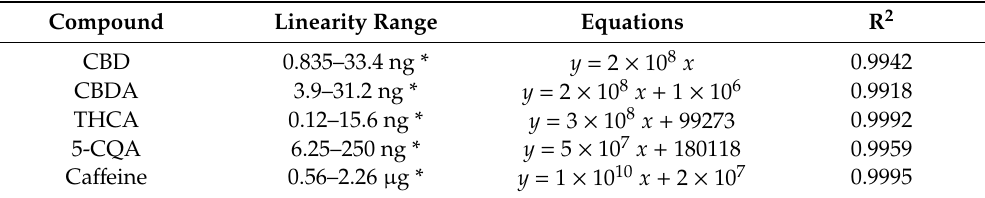
Table 1. Calibration Curves Used for Quantitation